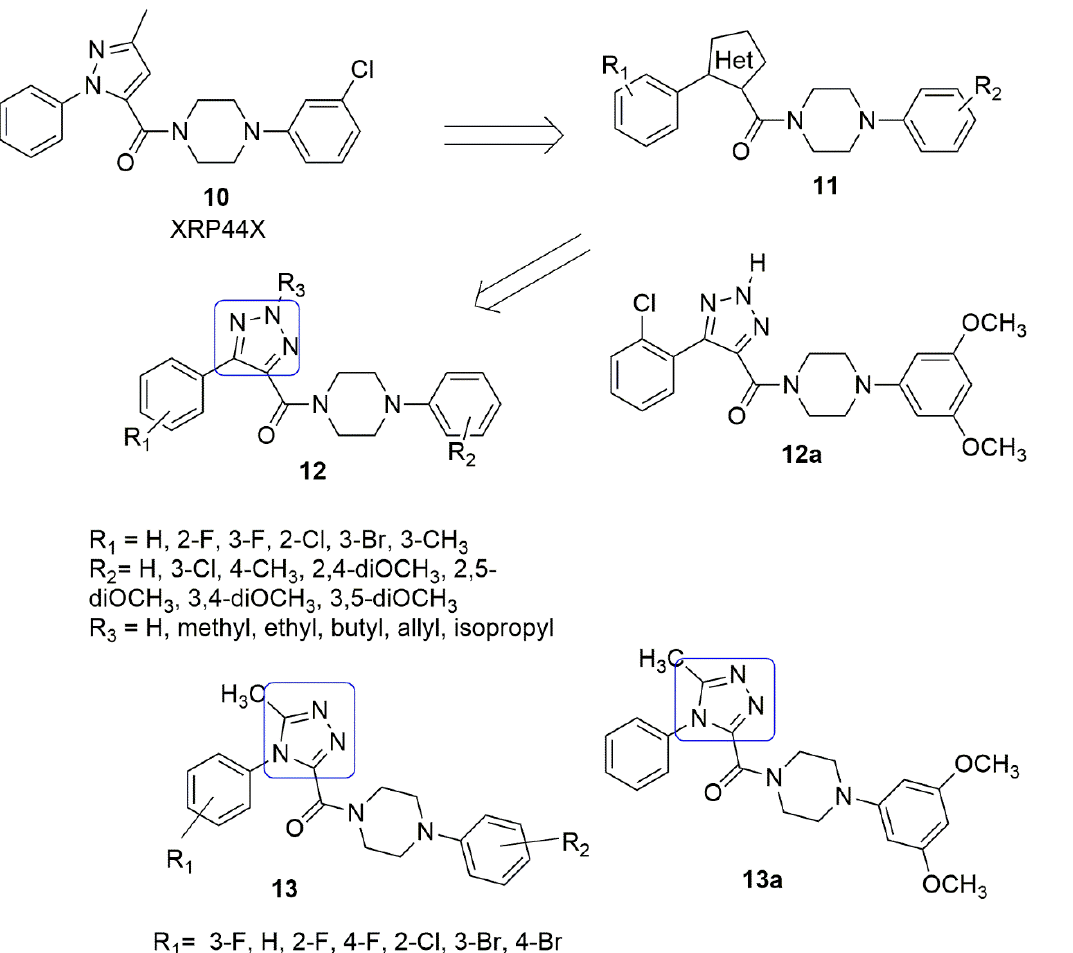
Figure 6. Chemical structures of arylpiperazine and triazole hybrids as a potential microtubule targeting agent.